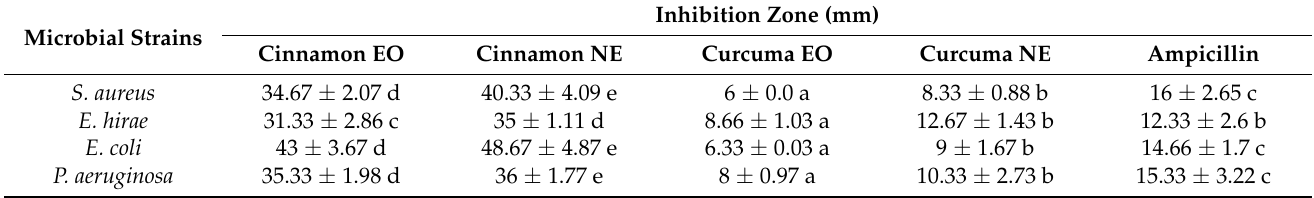
Table 4. The inhibition zone diameter, expressed in mm, of C. zeylanicum and C. longa essential oils (EO) and nanoemulsions (NE) as well as a positive control (ampicillin) against four bacterial strains. Inhibition Zone (mm) Microbial Strains